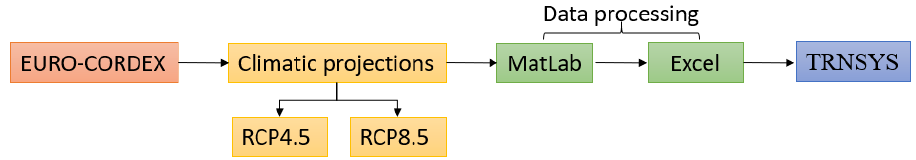
Figure 1. Flow chart containing all the steps followed for the analysis.